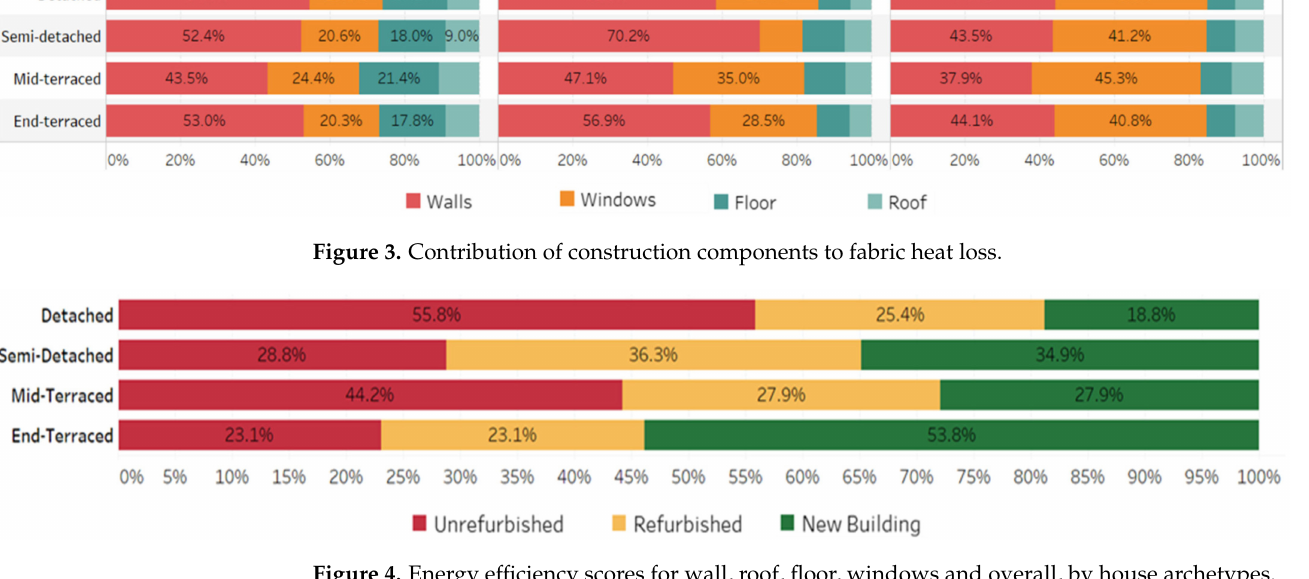
Figure 4. Energy efficiency scores for wall, roof, floor, windows and overall, by house archetypes.